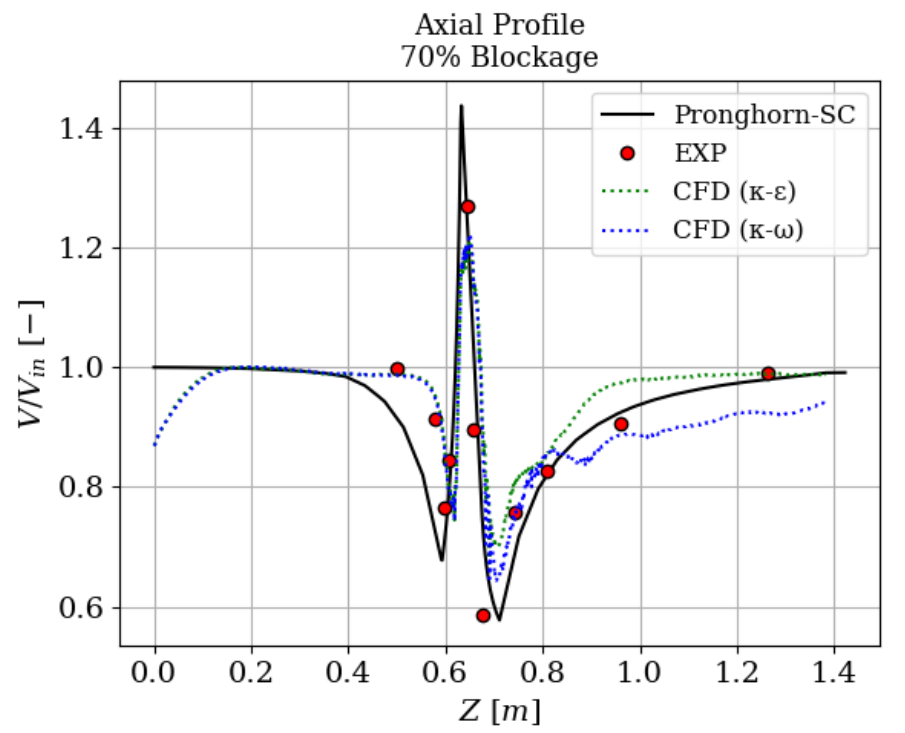
Figure 13. The 70% sleeve blockage with β =